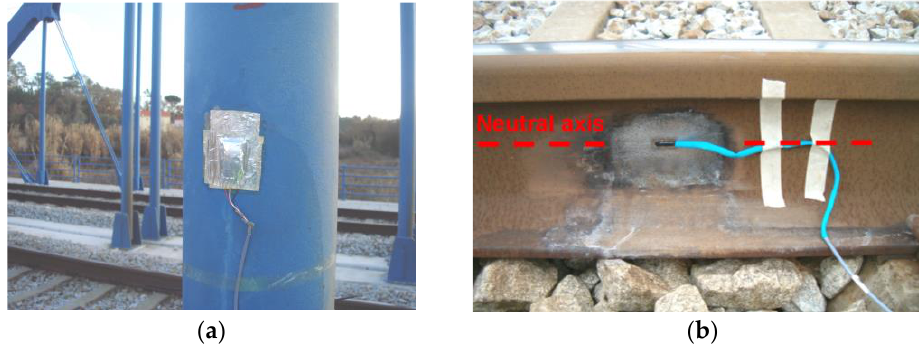
Figure 14. Strain measurement: ( a ) hanger P3; ( b ) rail.